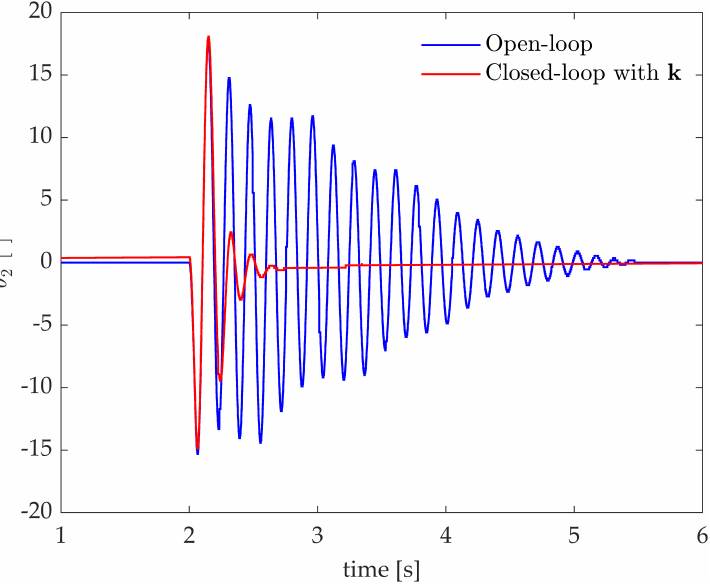
Figure 7. Test case 1: experimental impulse responses, relative angle of the